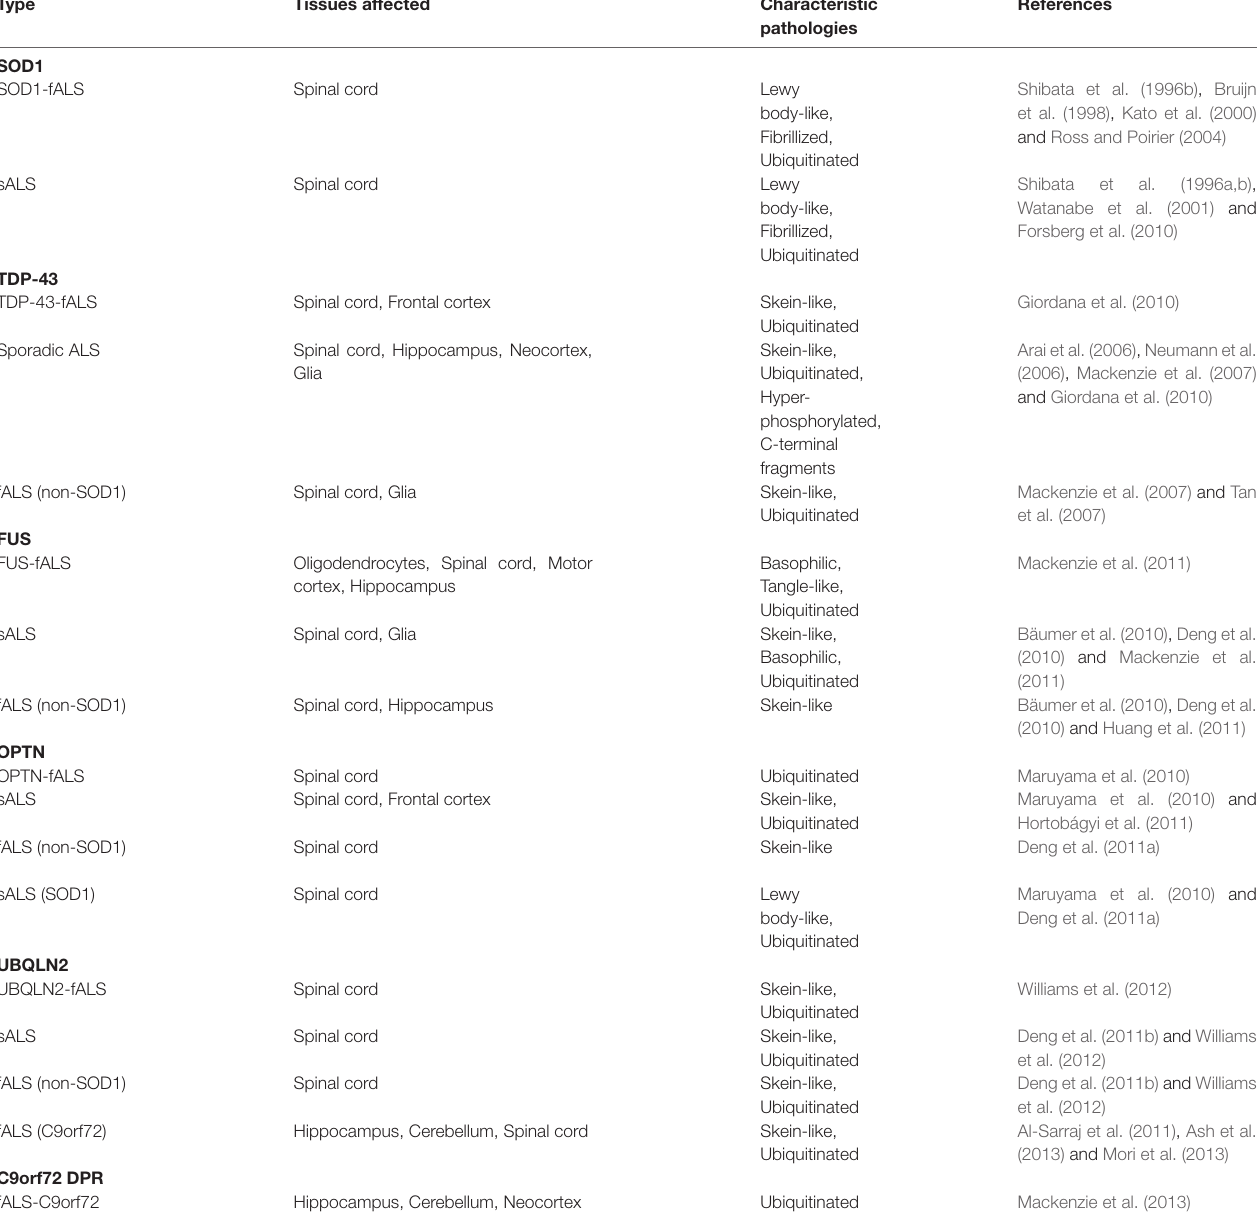
TABLE 1 | Overview of characteristics of protein aggregates formed by SOD1, TDP-43, FUS, OPTN, UBQLN2 and C9orf72 DPR in familial and sporadic cases of